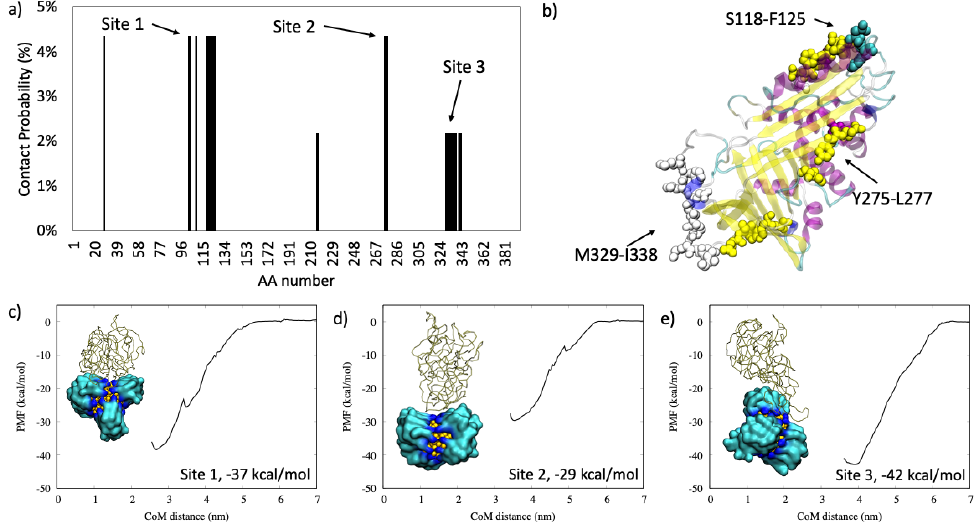
Figure 1. In panel ( a ): the contact probability for each residue upon α 1-antiproteinase binding to all-MUS AuNP. In panel ( b ): the graphical representation of the most probable binding sites in VdW, colored according to the protein secondary structure. In panels ( c – e ): the three binding modalities with the relative PMF curve.